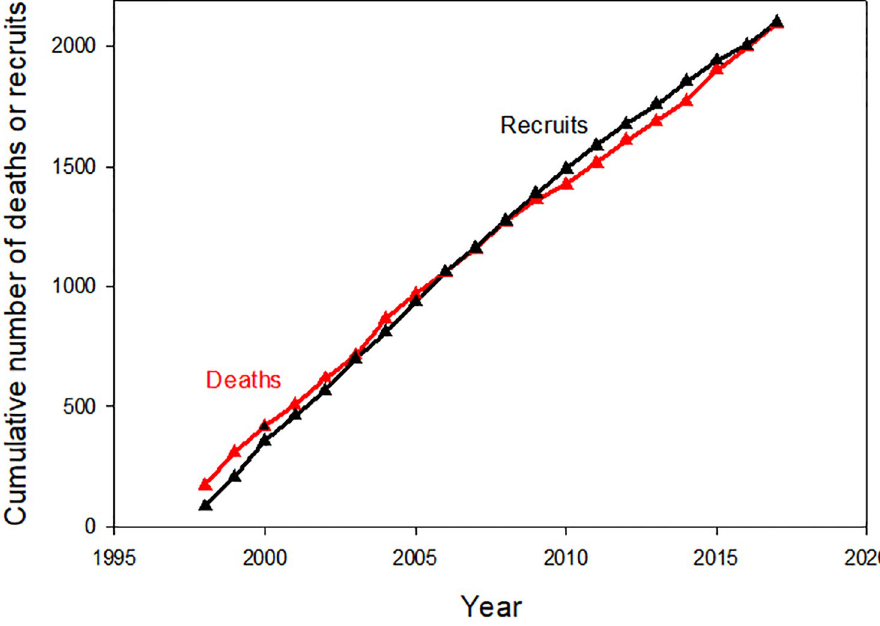
Fig 6. Stem dynamics. The cumulative total number of deaths (red line) and recruits (black line) for all stems � 10 diameter in 18 0.50 ha annually-censused long-term inventory plots from 1997–2017 at the La Selva Biological Station, Costa